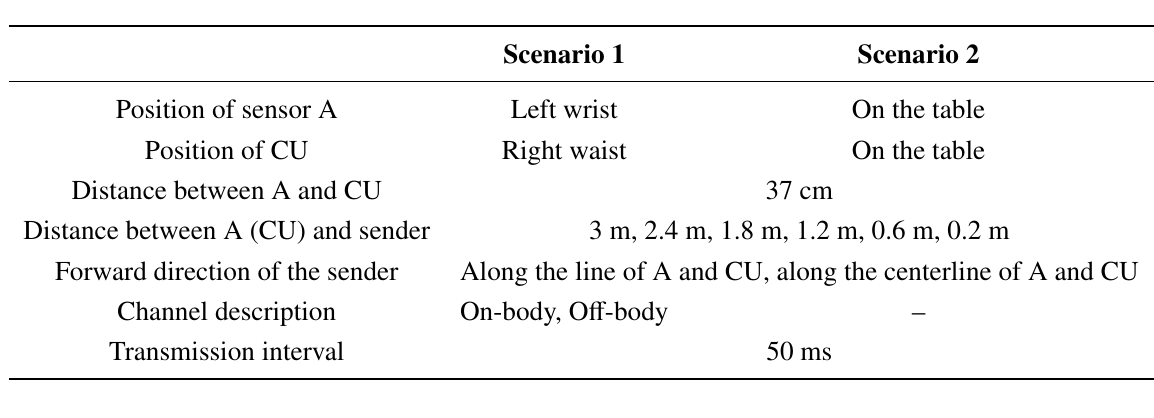
Figure 3. RSS traces when the sender forwards along the Line of A and